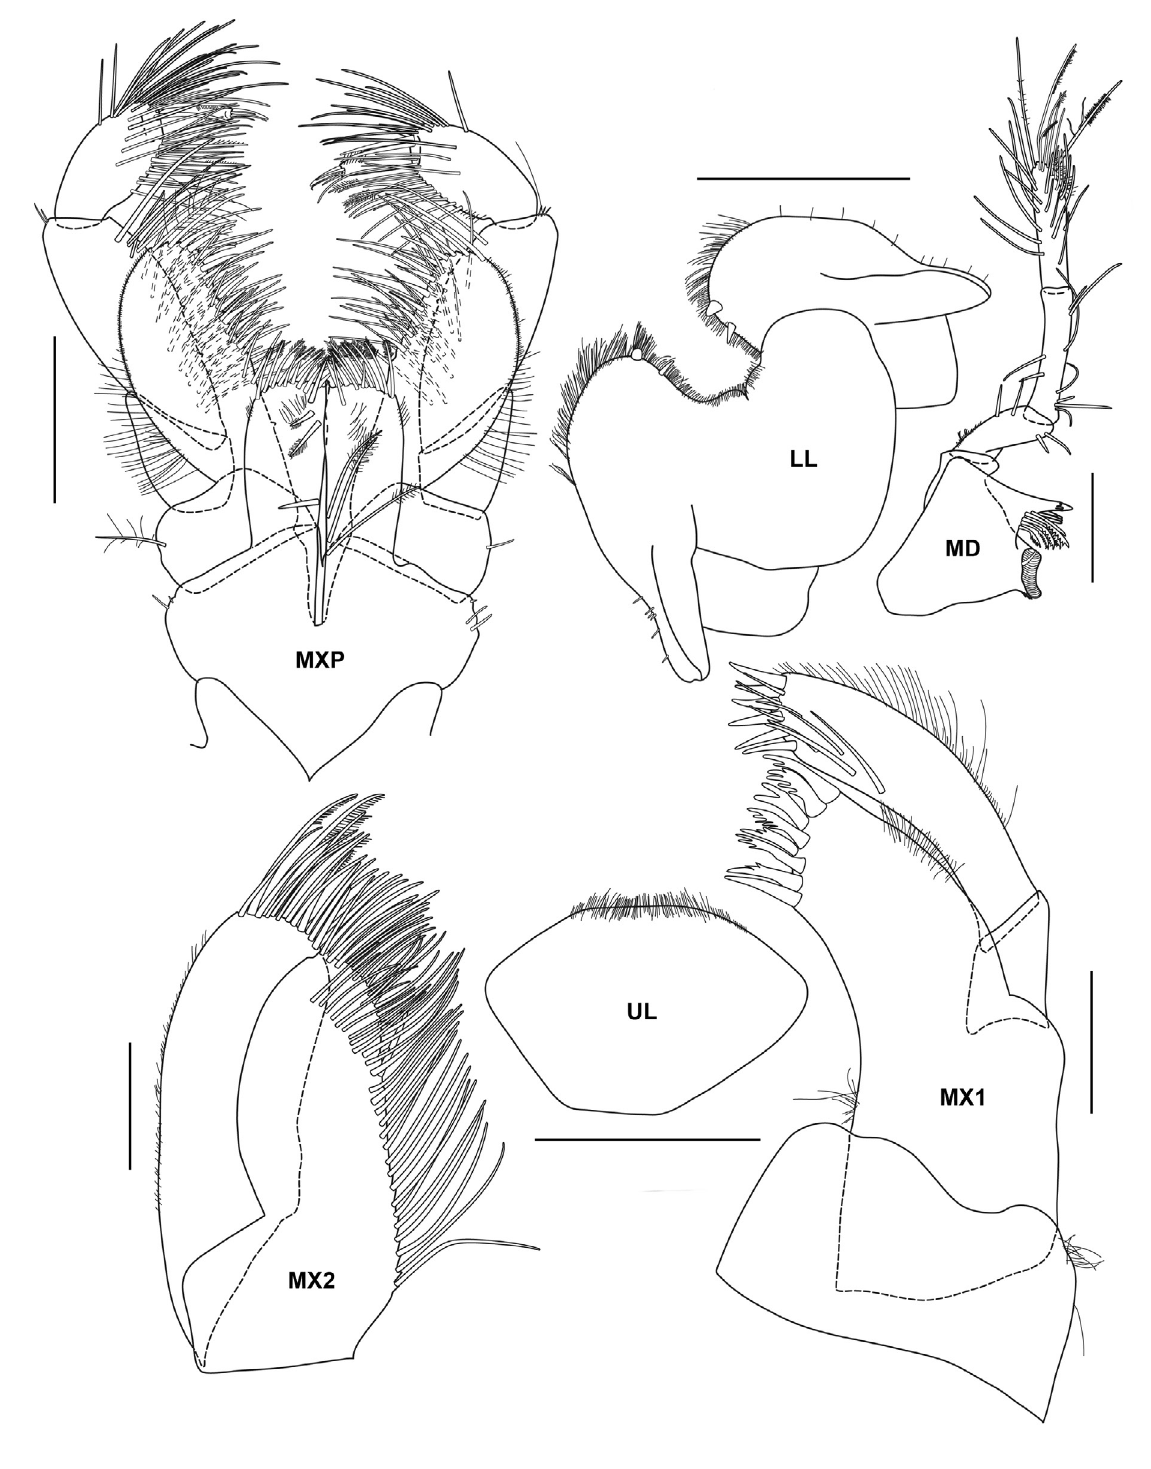
Fig. 13. Grandidierella sungeicina sp. nov., holotype, ♂ (ZRC 2018.0490). Scale bars: MXP = 0.2 mm; UL, LL = 0.25 mm; remaining scales = 0.1